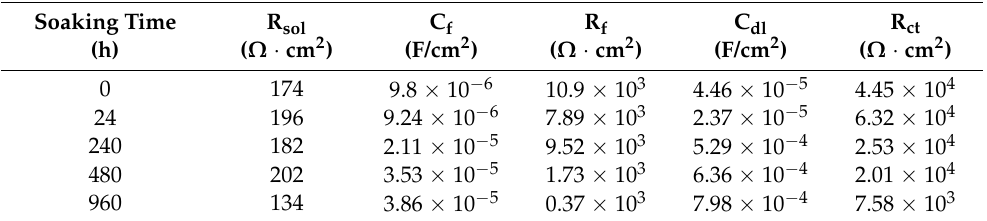
Table 3. Equivalent circuit parameters of impedance spectrum fitting of TP2 copper in acetic acid